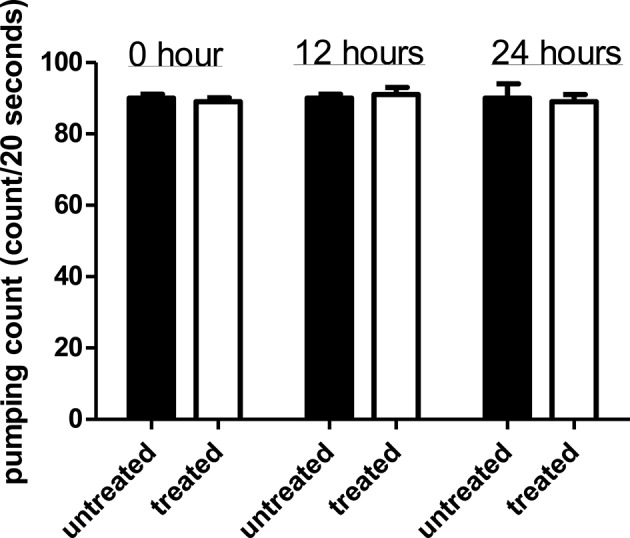
Streptomyces sp. CCB-PSK207 hexane partition does not impair C. elegans feeding activities. There is no distinguishable difference observed in the pumping rate count between the extract-treated and control worms at the indicated time points (t-test, p-value of 1.00, 0.392, and 1.00 at 0, 12, and 24 h time-points, respectively). Representative result is depicted from three independent experiments and values are expressed in mean ± SD.